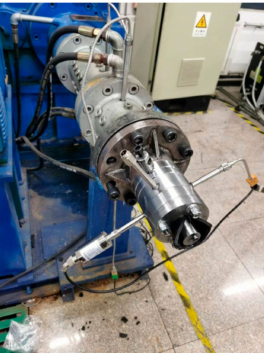
Figure 6. Structure of the die used in the extrusion experiments.